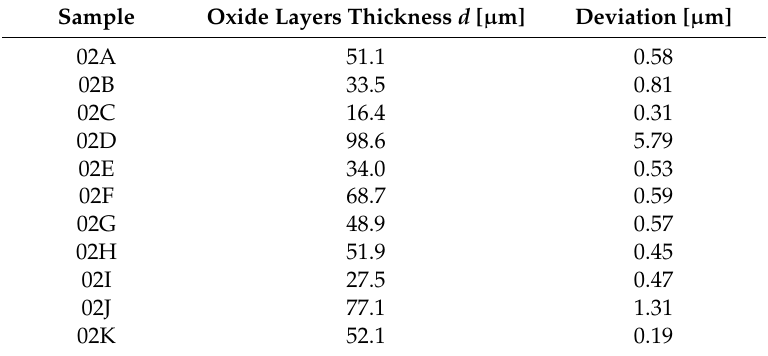
Table 4. SummaryofAl 2 O 3 coatingthicknessproducedinanodizingprocessandthermo-chemicaltreatment. Sample Oxide Layers Thickness d [ µ